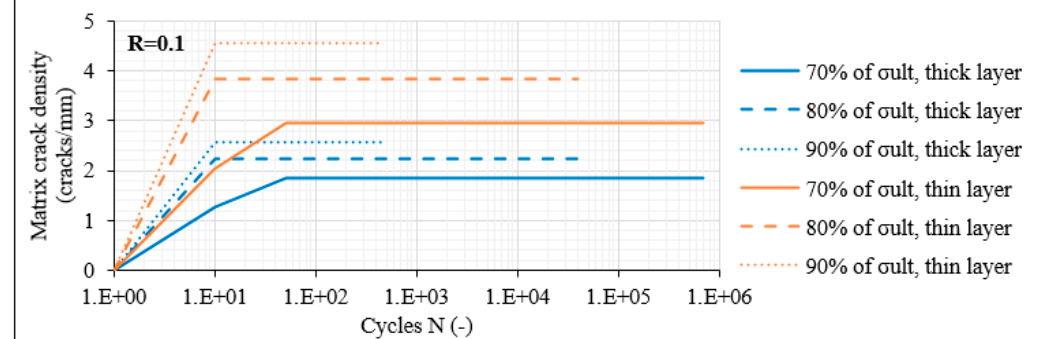
Figure 13. Matrix crack density versus N in [0°/60°/ − 60°] 2s laminates for R = 0.1.